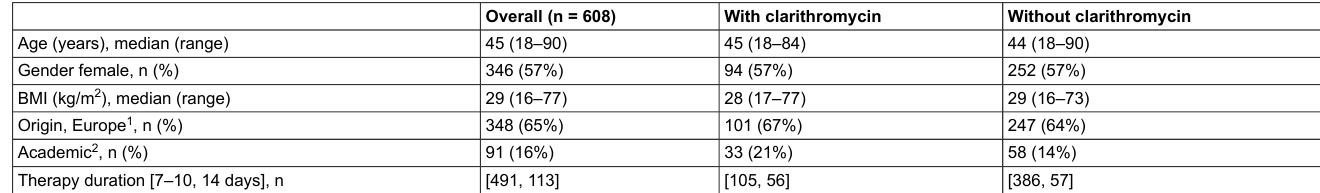
Table 1: Baseline clinical characteristics.